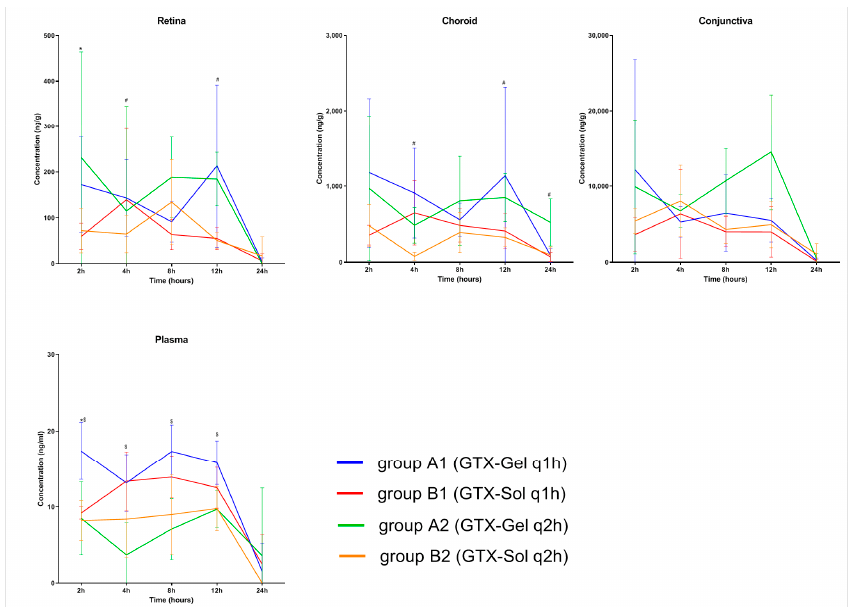
Figure 2. Concentration-time values of gatifloxacin in ocular tissues and plasma. Each point repre- sents the mean concentration ( n = 5–6). ± : the standard error of the mean. *: The difference was statistically significant between groups A1 and B1; #: The difference was statistically significant between groups A2 and B2; $: The difference was statistically significant between groups A1 and A2; &: The difference was statistically significant between groups B1 and B2 ( p < 0.05). Table 4. AUC 0–24 values of gatifloxacin in ocular tissues and plasma. Biological Specimens